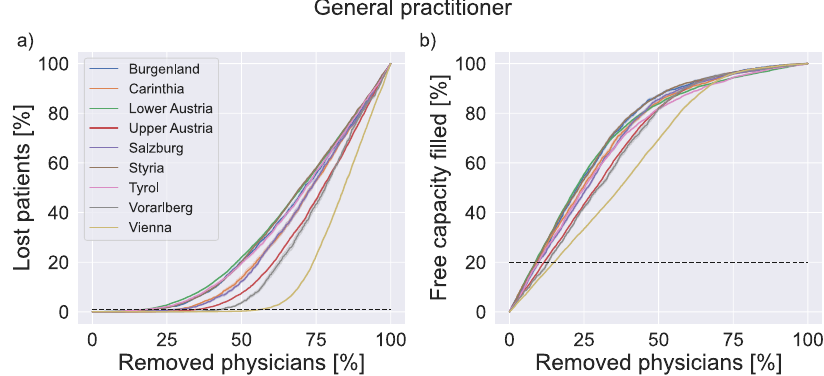
Fig. 2 Time development of quantities of interest. Development of lost patients ( a ) and free capacity ( b ) in federal states. Averaged model results in the example of general practitioners as physicians are gradually removed from the system. Dashed lines indicate critical limits of 1% lost patients and 20% remaining free capacity, respectively. Lines show mean values, con fi dence intervals are standard deviations shown as error bands (smaller than symbol size).